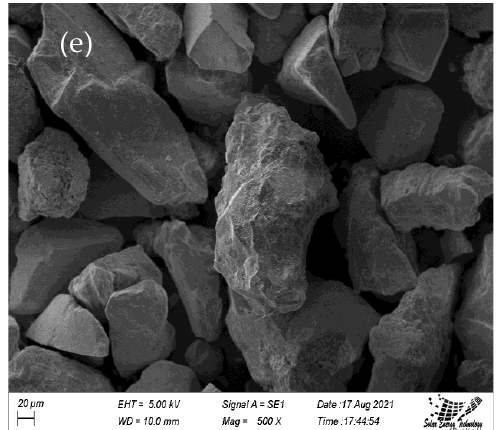
Figure 4. (a – e). SEM images of Nijhum Dwip, Domar Char, Nimtoli, Qazir Bazar and Rahmat Bazar grains, respectively; scale bar = 20 µm.